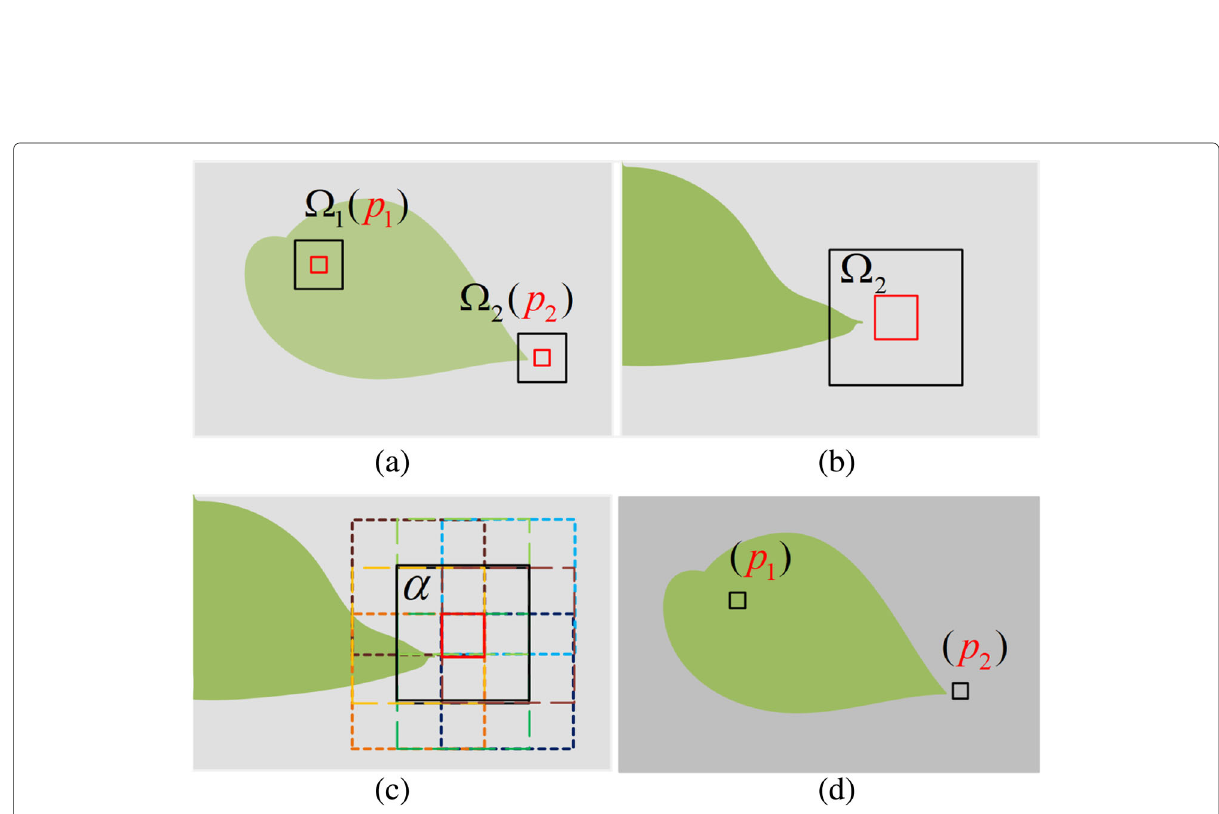
Fig. 4 Analysis of the modified DC. a Input image. b Information in which the classic DC algorithm is based. c Information in which the proposed DC algorithm is based. d Recovered image using